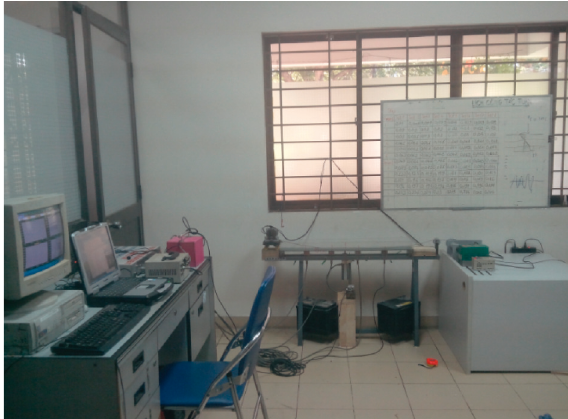
Figure 8: Arrangement of the experiment model.